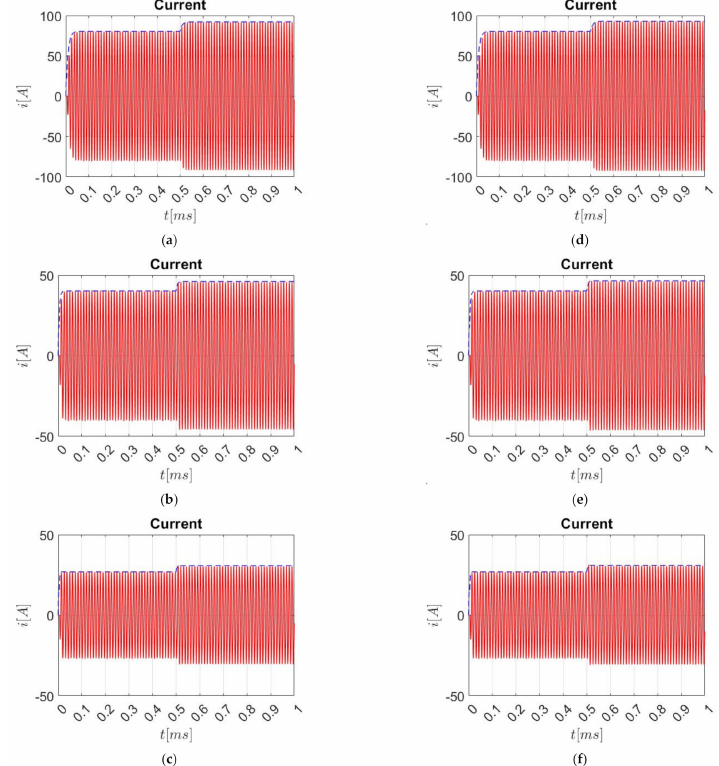
Figure 6. Inverter output current (solid red line) obtained from MATLAB simulation and its envelope (dashed blue line) obtained in Simulink as the output of the model (14). ( a ) α P = π /4, R = 5 Ω ; ( b ) α P = π /4, R = 10 Ω ; ( c ) α P = π /4, R = 15 Ω ; ( d ) α P = π /3, R = 5 Ω ; ( e ) α P = π /4, R = 10 Ω ; ( f ) α P = π /3, R = 15 Ω